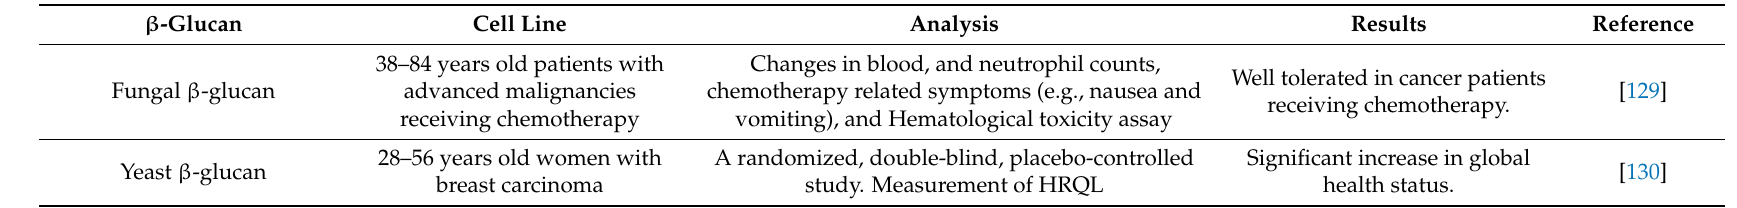
Table 4. Antitumor effects of β -glucans—human